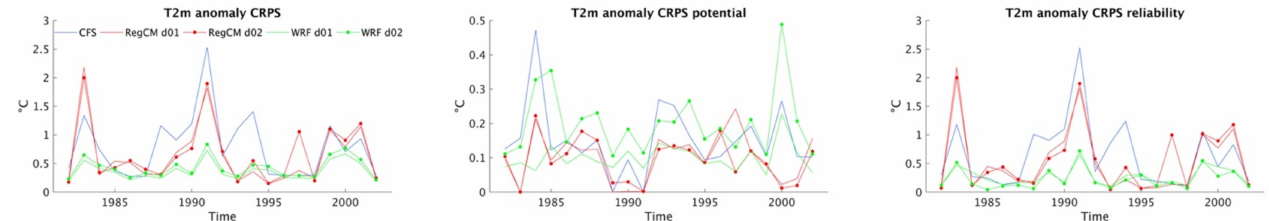
Figure 7. D02 spatial averaged Continuous Ranked Probability Score (CRPS) for the CFS (blue), RegCM (red) and WRF (green). For RegCM and WF solid lines represent D01 simulations and doted lines D02 simulations.